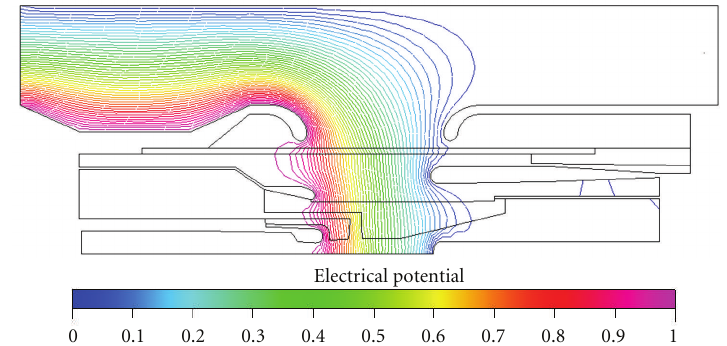
Figure 11: Typical electrostatic field distribution for a chosen contact